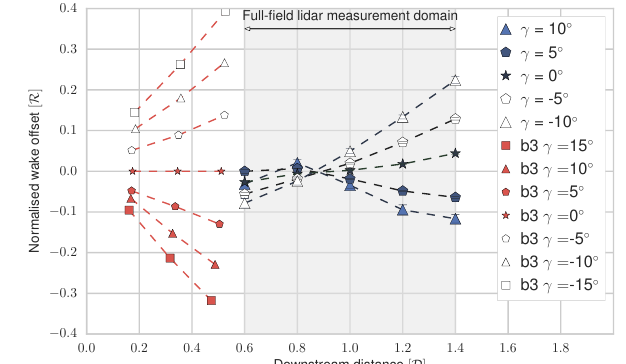
Figure 10. Comparison of published wind tunnel and full-field mean near-wake paths in the frame of reference of the turbine. The wind tunnel paths (from ∼ 0.2 D to ∼ 0.5 D ) have been digitised from Grant et al. (1997). Full-field paths from lidar averaged in 5 ◦ bins of yaw